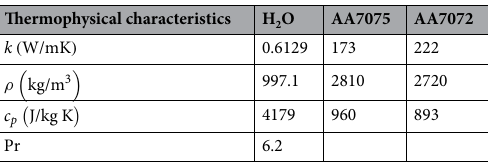
and x axes, C the con- − −